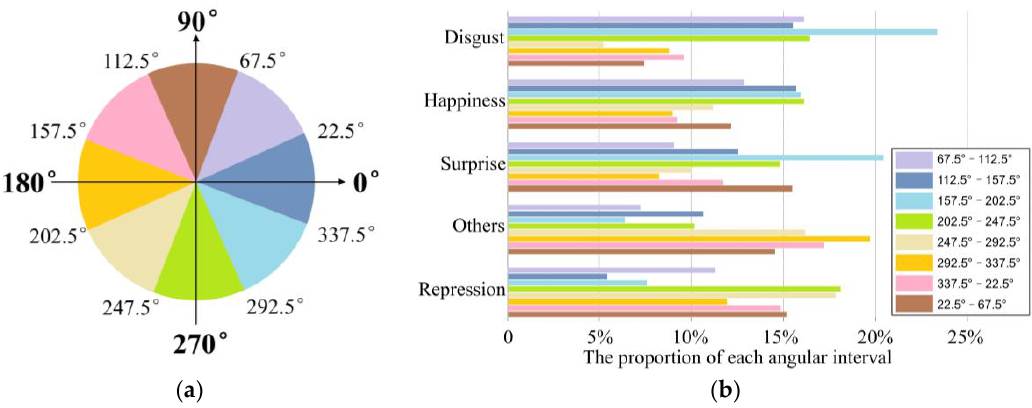
Figure 3. The statistical information on the temporal motion direction of different samples, which belong to the five major classes in Chinese Academy of Sciences Micro-expression2 (CASME-II). The statistics for temporal motion direction show a wide variation in the distribution of different samples, which leads to the fact that the sampling range of the temporal direction should be cover all directions. ( a ) The pie graph illustrates the division of eight angular intervals. Eight angular intervals contain the pixel moving direction in the XT, YT plane (i.e., XT:337.5 ◦ –22.5 ◦ and 157.5 ◦ –202.5 ◦ , YT:67.5 ◦ –112.5 ◦ and 247.5 ◦ –292.5 ◦ ) and the non-orthogonal plane region (i.e., the other regions except in the XT and YT planes). ( b ) The directional statistical of pixel motion in eight angular